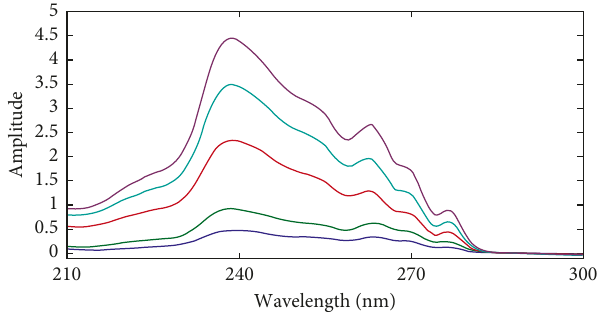
Figure 6: Ratio spectra of laboratory-prepared mixtures of acli- dinium (5–40 µ g/mL) and formoterol (5–10 µ g/mL) using 8 µ g/mL of formoterol as a divisor after subtraction of the constant.